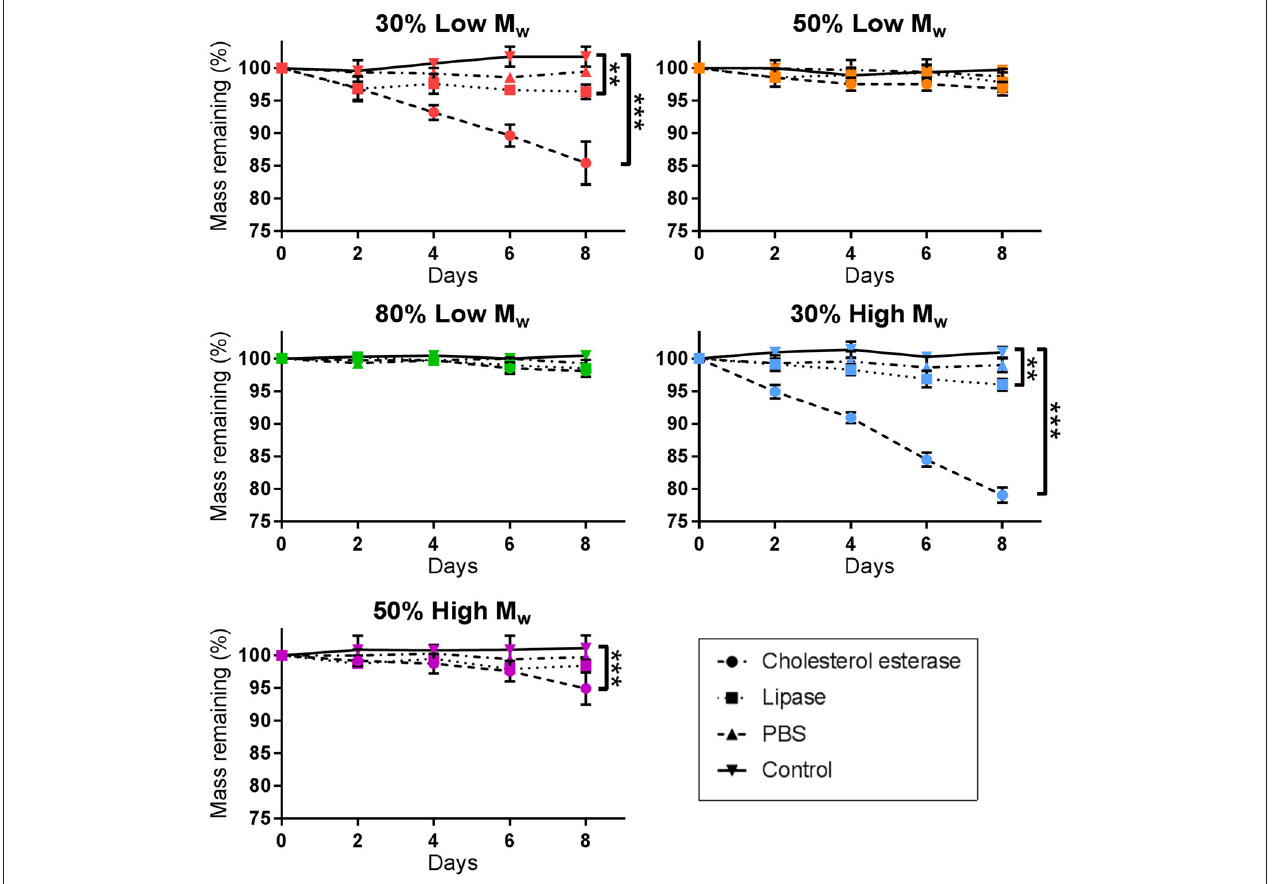
FIGURE 7 | Degradation of PGS-M treated with cholesterol esterase, lipase and PBS. After 8 days, cholesterol esterase produced significant degradation in both 30% DM polymers and the 50% High Mw PGS-M. Lipase only produced significant degradation in the 30% DM polymers. PBS did not produce significant degradation in any sample ( n = 3). The degree of significance is indicated as *** P ≤ 0.001, ** P ≤ 0.01 and * P ≤